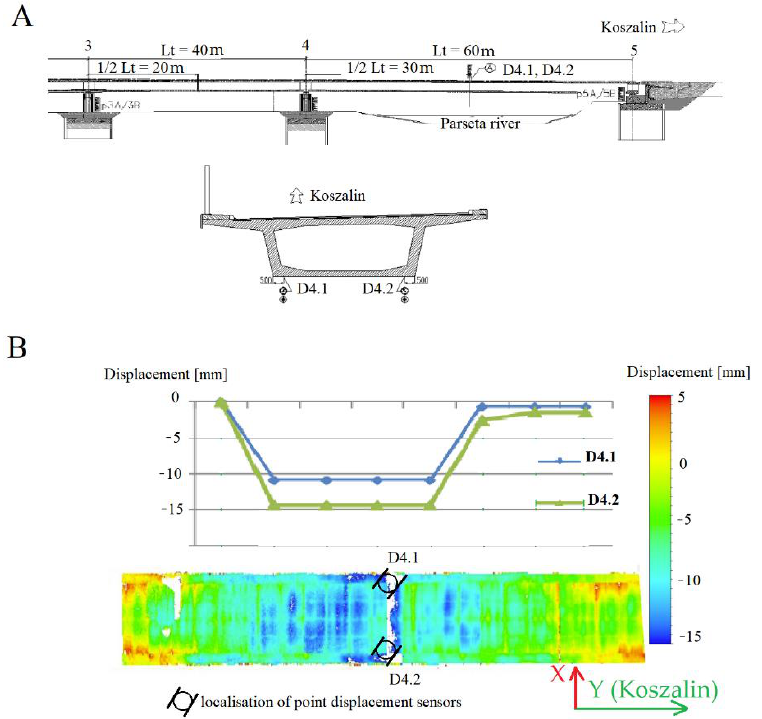
Figure 3. Localisation of potentiometric sensors placement on the M78 bridge ( A ) and Comparison of the test load results of the laser scanner to the potentiometric sensors ( B ).